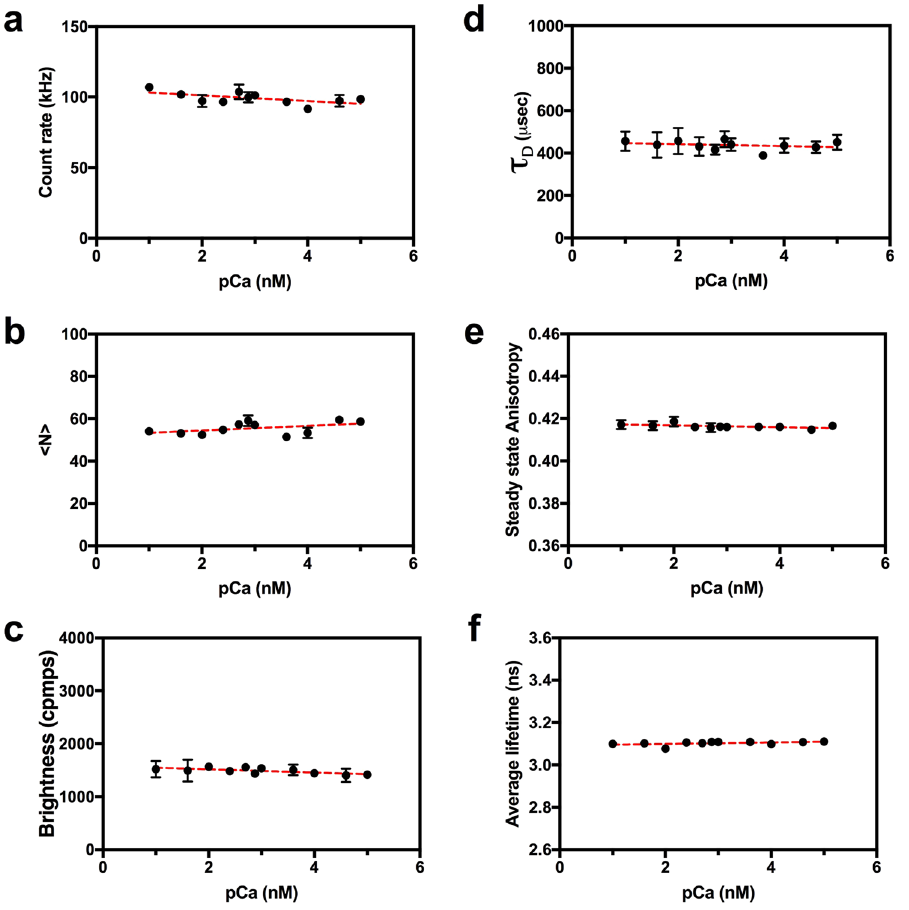
Figure 8. A uto-FPFA characterization of Venus monomers, a control for non-specific calcium changes in Venus photo-physics. Auto-FPFA was used to measure count rate ( a ), < N > ( b ), brightness ( c ), diffusion time ( τ D , d ), steady state anisotropy ( e ), and average lifetime ( f ) of two different homogenates prepared from cells expressing Venus. Homogenates were diluted into buffers with defined calcium concentrations. Each point is the mean ± SD (N = 4, two from each homogenate preparations). Dashed lines are a linear